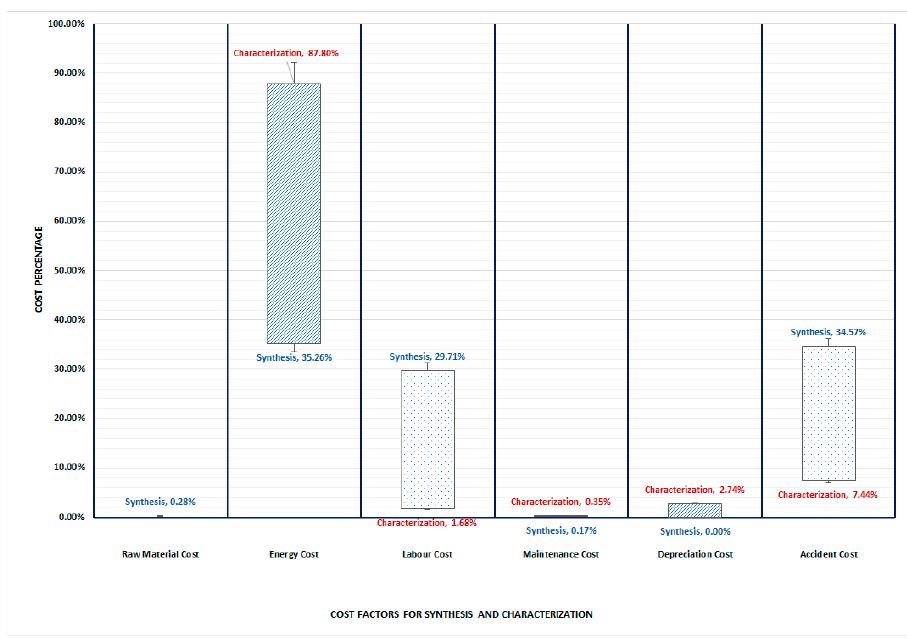
Figure 4. Percentage distribution of TCO cost factors per studied synthesis and characterization process.